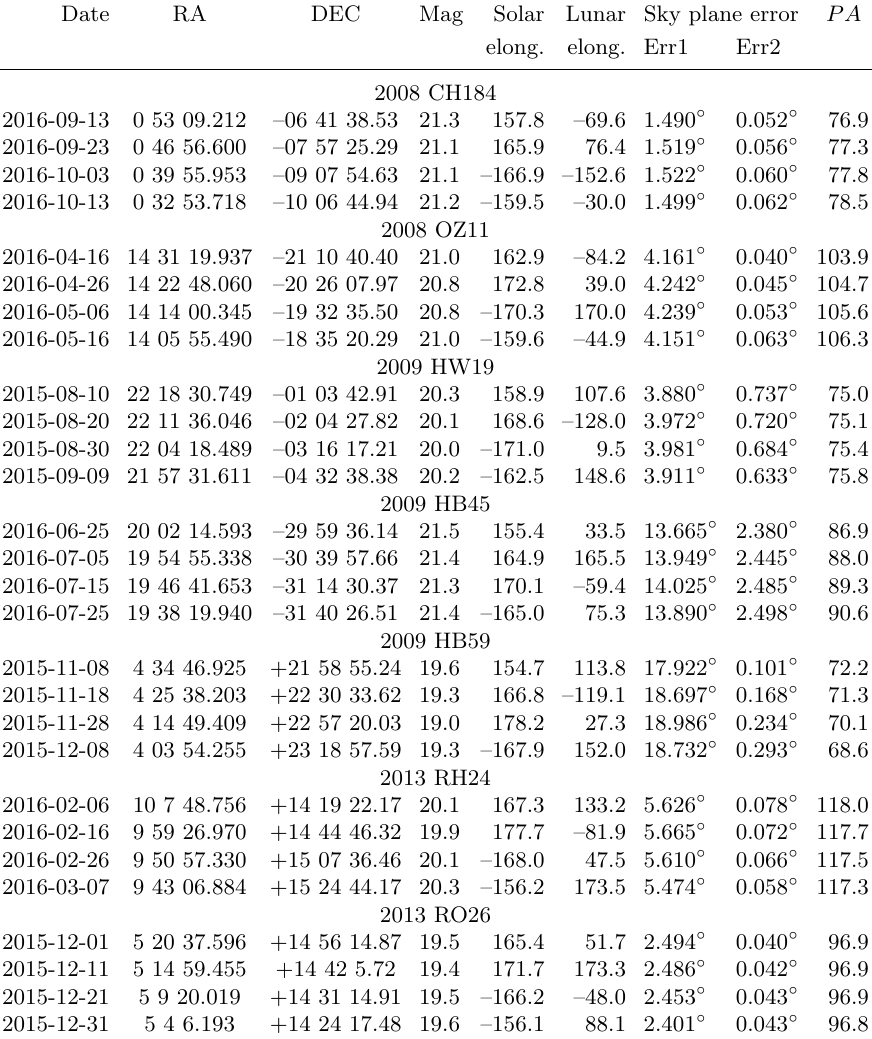
Table 6. Ephemerides for 2015–2016 for the asteroids with orbits of low accuracy discovered at the Baldone Observatory (for a geocentric